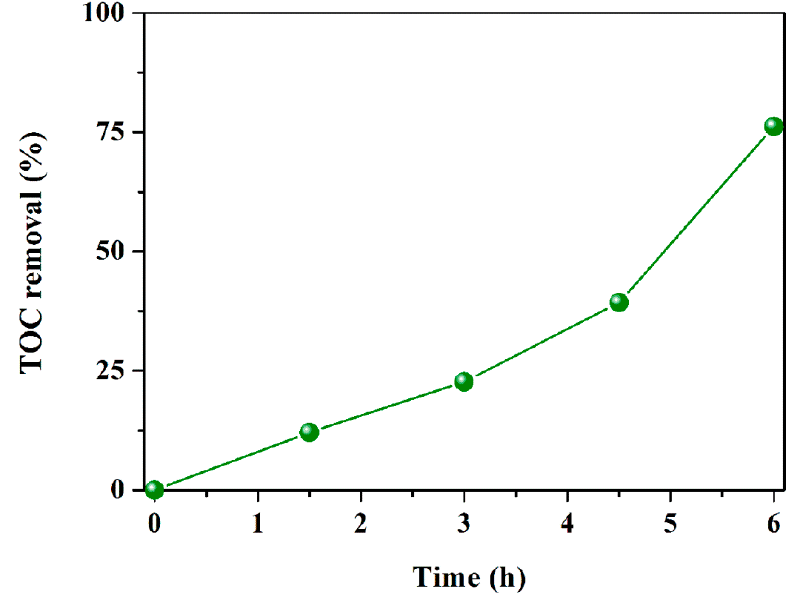
ffi ciency of CIP over